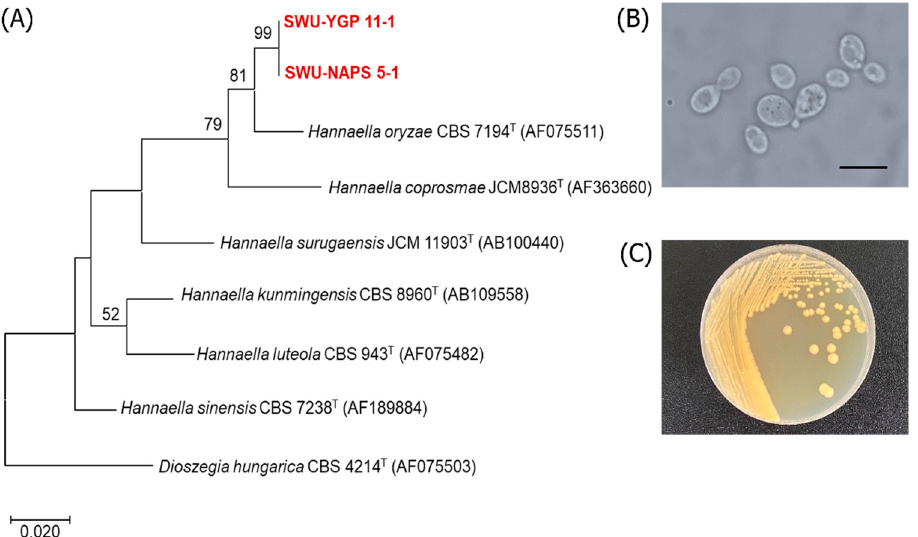
Figure 1. Phylogenetic tree ( A ) showing the positions of the strains SWU-YGP 11-1 and SWU-NAPS 5-1 and their related species constructed by the maximum-likelihood method based on the D1/D2 of the LSU rRNA gene sequences. Dioszegia hungarica CBS 4214 T was used as an outgroup. The numerals represent the percentages from 1000 replicate bootstrap resampling (a frequency of less than 50% is not shown). The cells ( B ) and colony ( C ) morphology of SWU-YGP 11-1 grown on YM agar for 48 h. The bar represents as 10 µm.